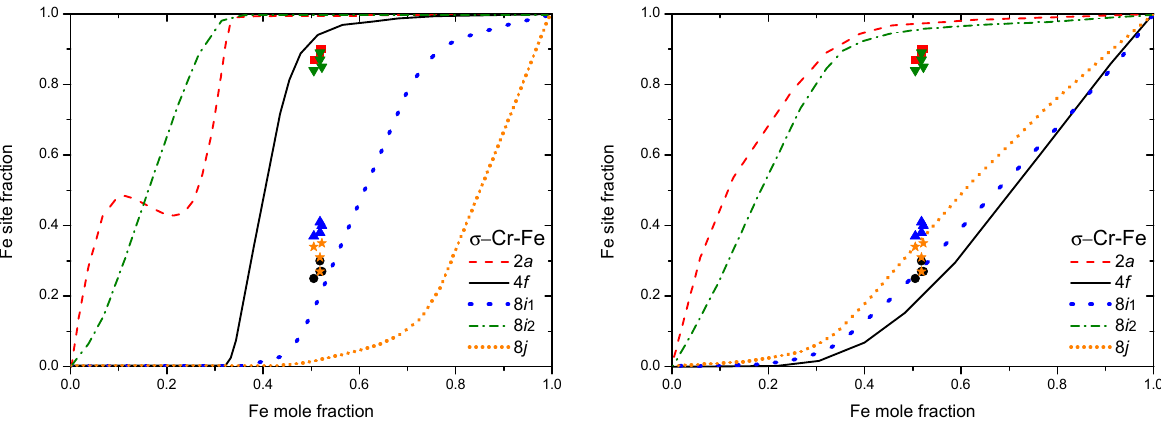
Figure 6. Fe site fraction in σ Cr-Fe, obtained by CWM-CVM at 500K ( left ) [28], and obtained by BWA at 1,000 K (right) [38]. Experimental points from